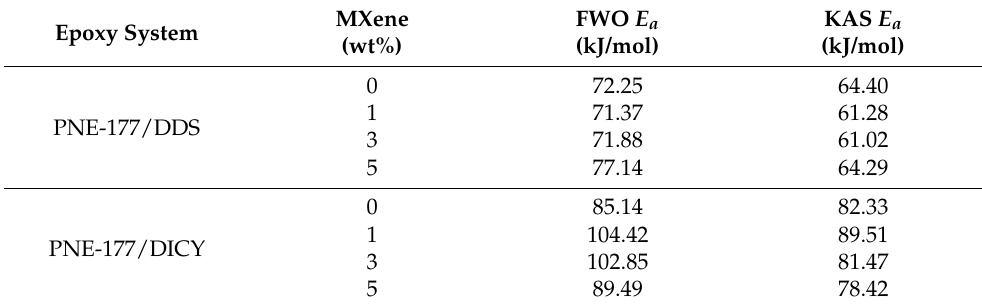
Table 3. The activation energy of PNE-177/DDS and PNE-177/DICY systems based on both fitting methods.